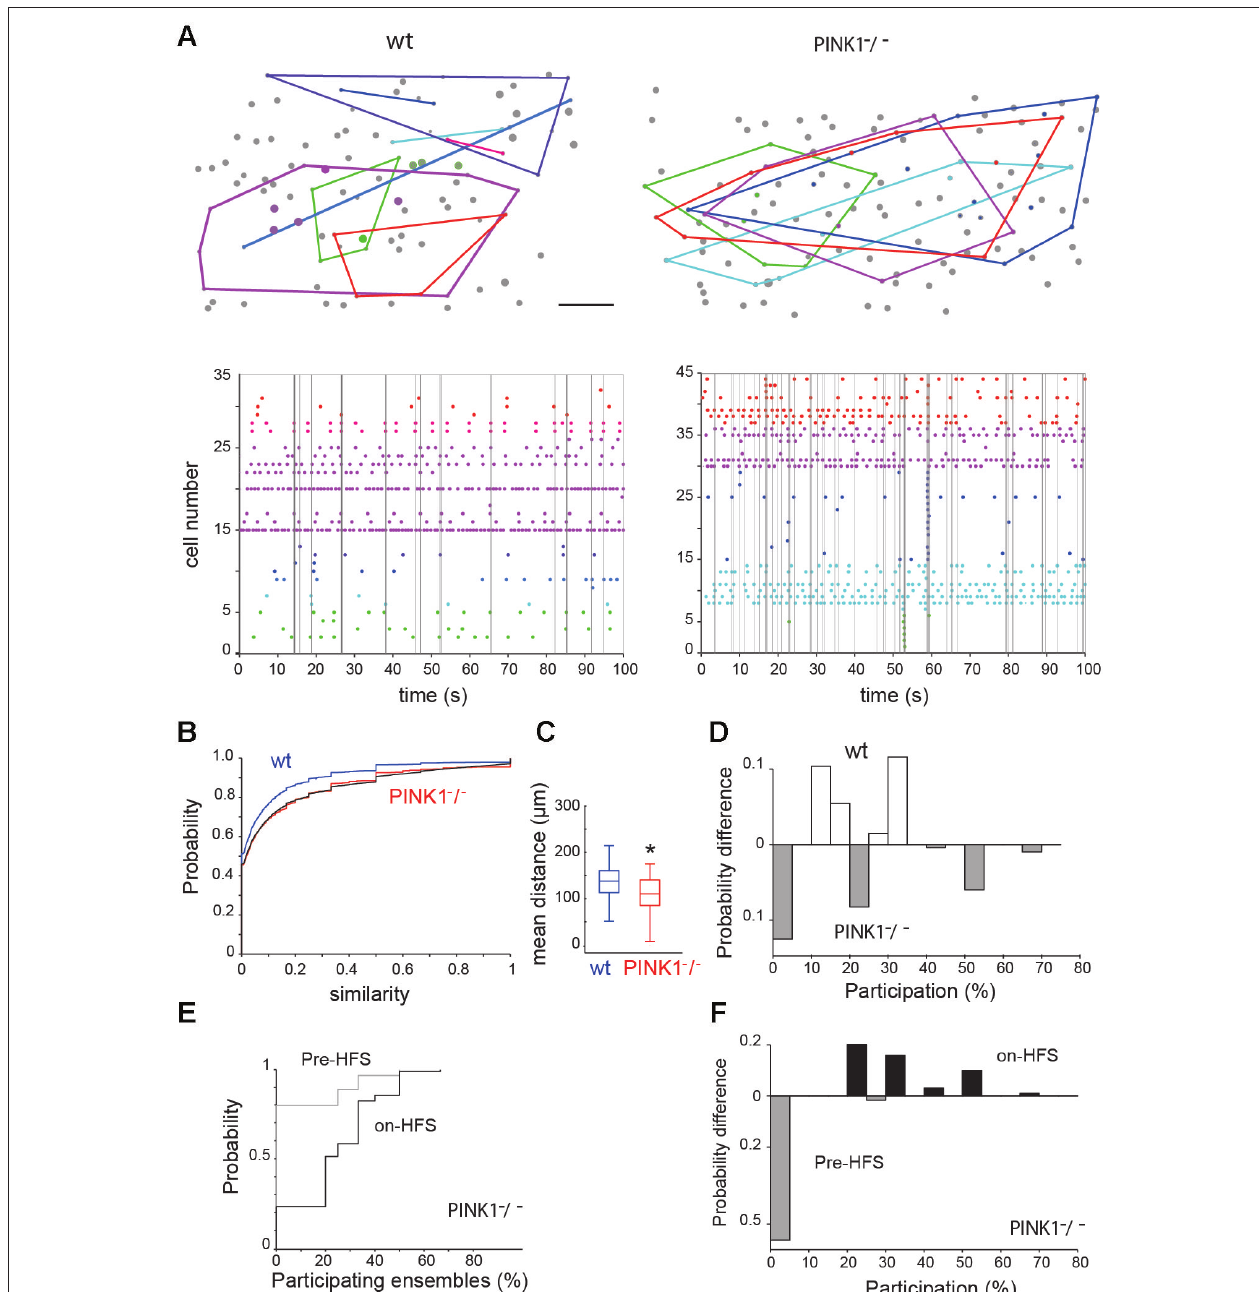
neurons in an ensemble. Center lines give the median, boxes give the inter-quartile range, and whiskers extend to 1.5 times that range. (D) Histogram of the difference between the wt and PINK1 − / − networks in the probability of ensemble participation in network events. Participation is defined as the percentage of ensembles with more than half their members active during the network event. (E) Cumulative distributions of ensemble participation in network events before and during HFS. (F) Histogram of the difference between before-HFS and during-HFS in the probability of participation, showing that HFS increased ensemble participation in network